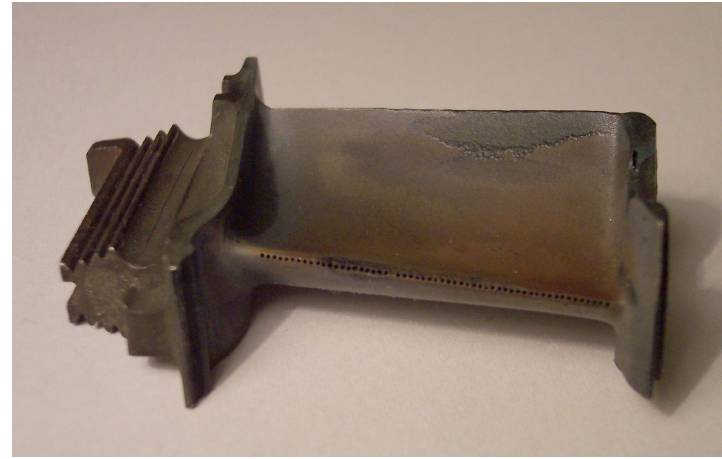
Figure 3. Damaged blades resulting from exposure to high temperature and stress